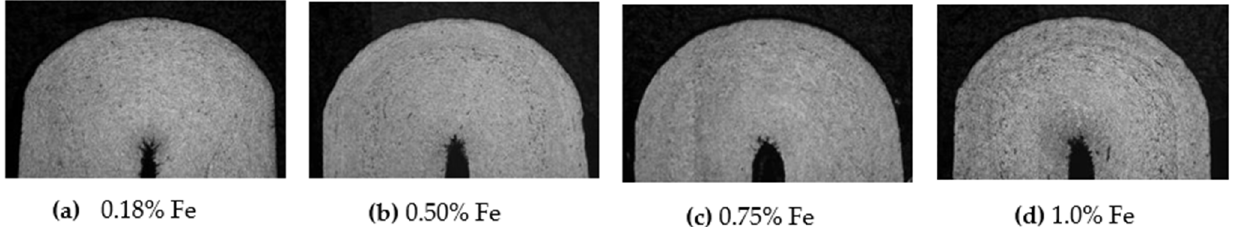
Figure 13. Effect of Fe content on full bending of strip cast by the VHSTRC. Cold-rolled and annealed 1-mm-thick strip was bent. Aluminum alloy: 6016 and Fe added 6016, Roll speed 60 m/min, Roll diameter: 300 mm, Roll width: 100 mm, Roll load: 0.14 kN/mm, Solidification length: 100 mm.